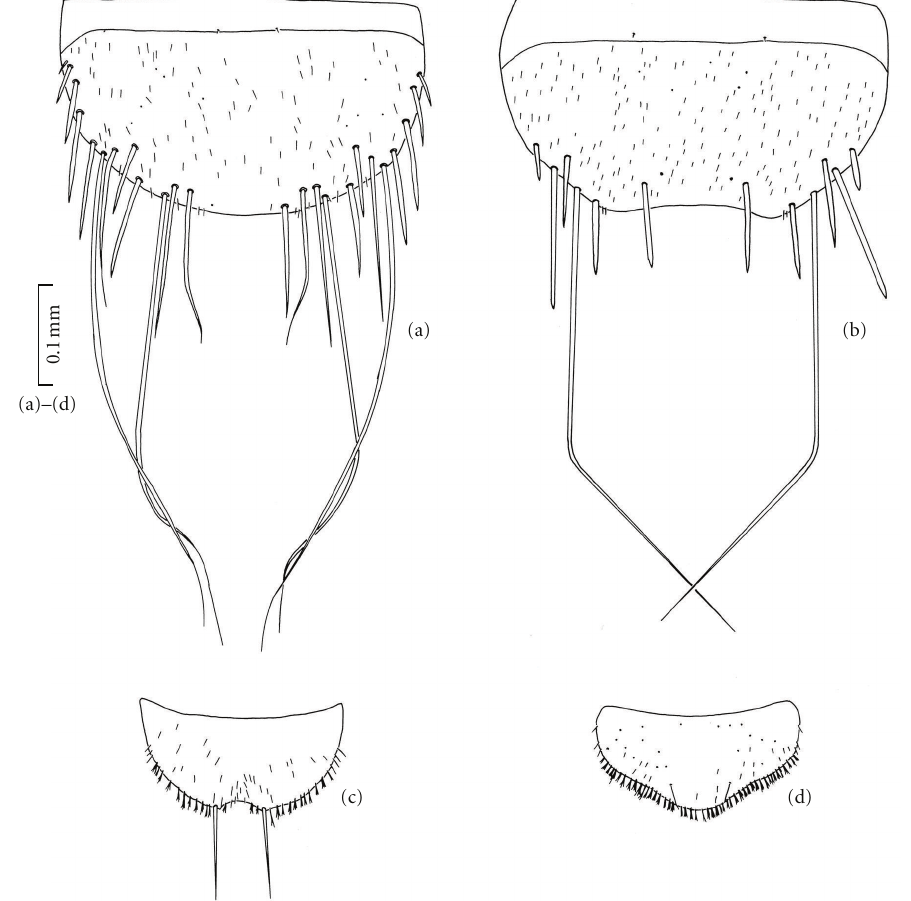
Figure 5: Hydrocyphon takizawai sp.n., larva. (a) Sternite VIII; (b) tergite VIII; (c) tergite IX; (d) sternite IX.